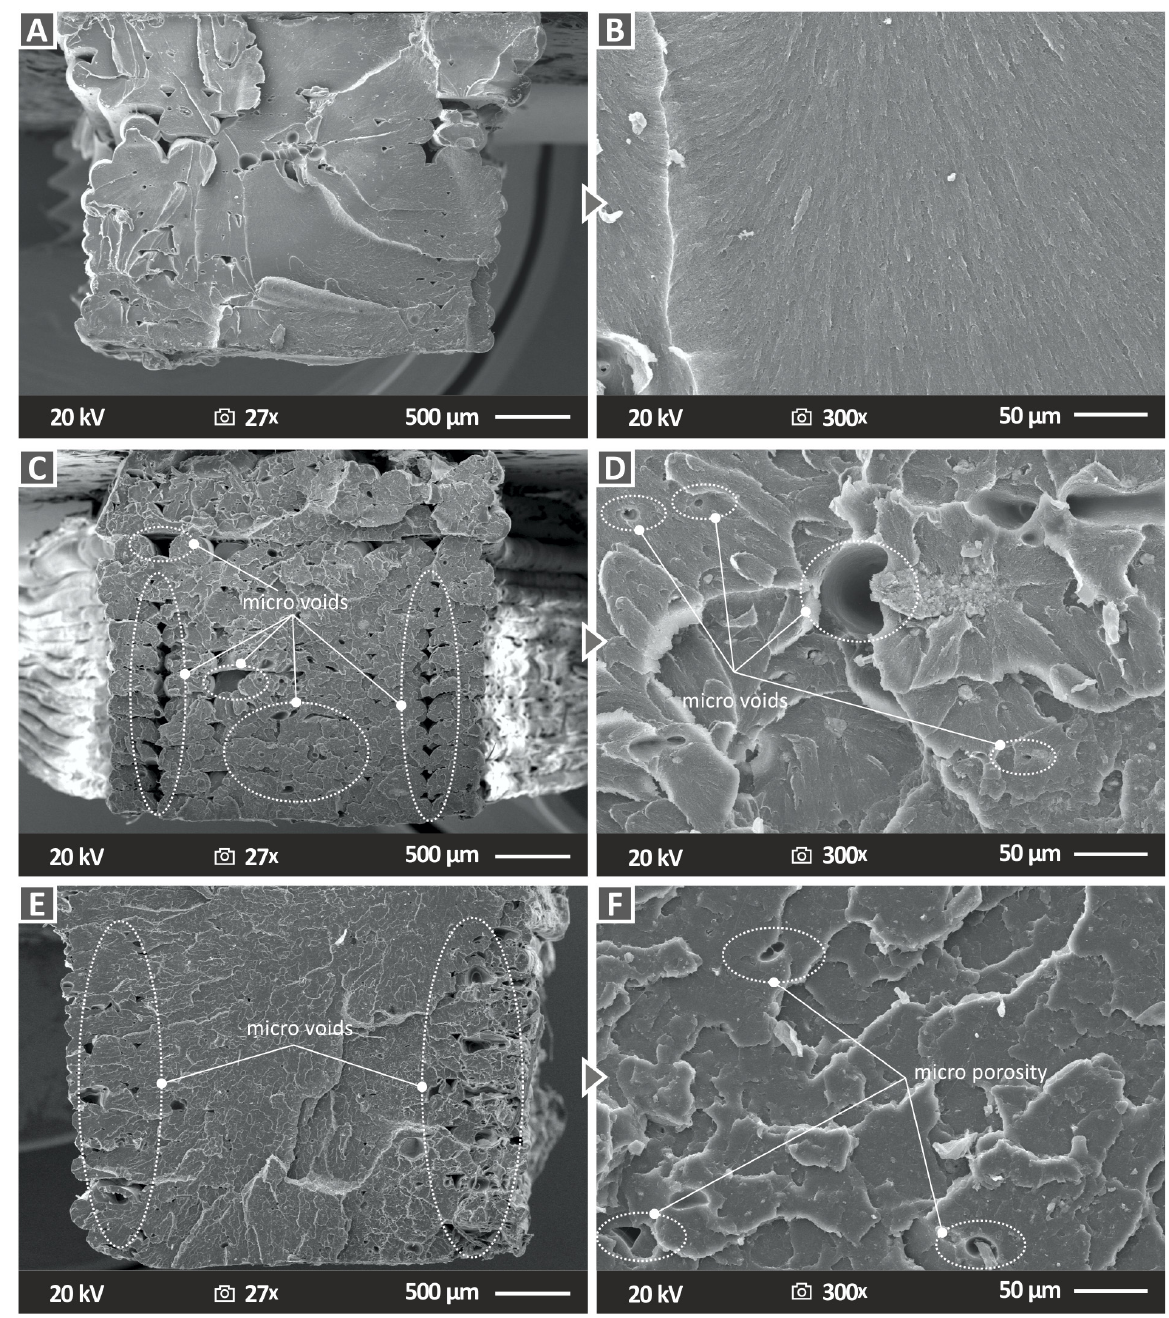
Figure 13. Fracture surface SEM images for ( A ) pure ABS at 27× magnification, ( B ) pure ABS at 300× magnification ( C ) ABS/TIN 4 wt. % at 27× magnification ( D ) ABS/TIN 4 wt. % at 300× magnification ( E ) ABS/TIN 8 wt. % at 27× magnification ( F ) ABS/TIN 8 wt. % at 300× magnification.